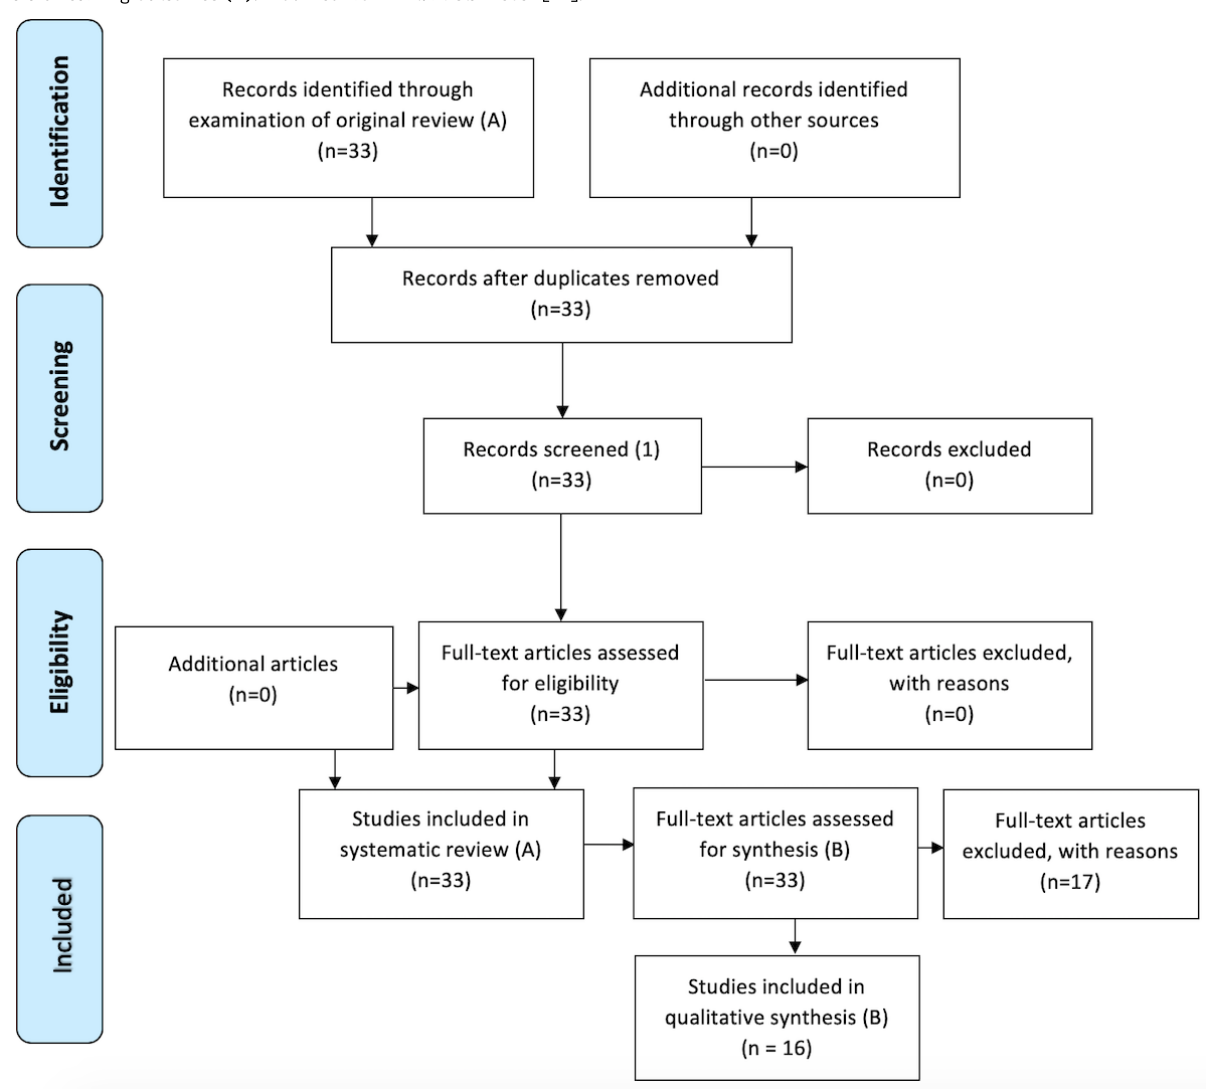
Figure 1. Preferred Reporting Items for Systematic Reviews and Meta-Analyses (PRISMA) flow diagram: systematic review (A) for a synthesis paper on MOOC learning outcomes (B). Modified from Alturkistani et al